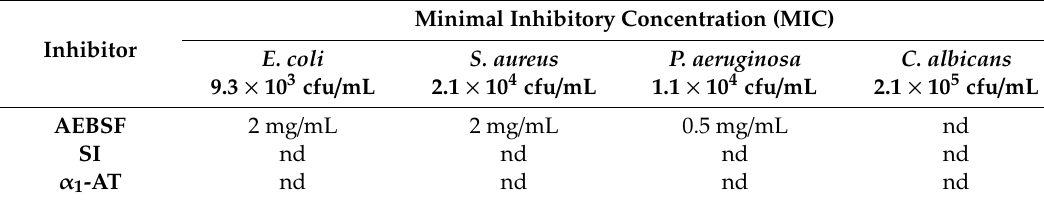
Table 3. MIC values for three serine protease inhibitors.